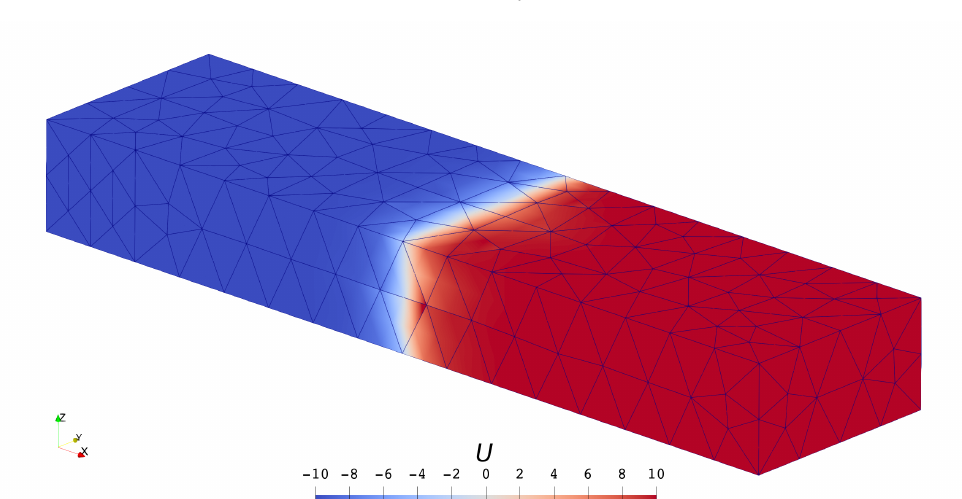
Figure 4. Third-order solution of Problem 1 on big ( h ≈ 2 − 2 )